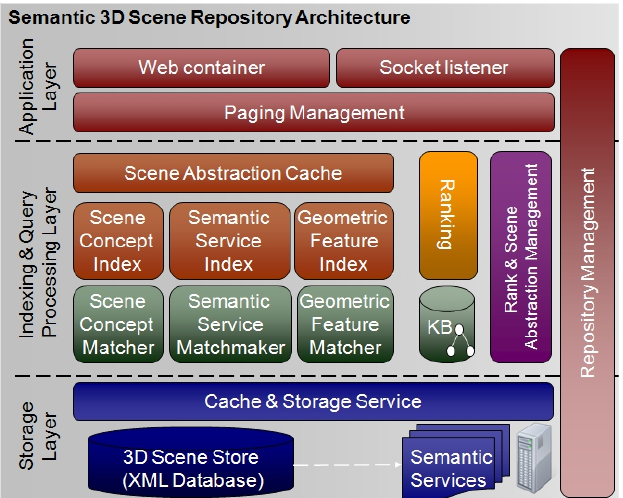
Figure 10. Architecture of the iRep3D 2.0 scene